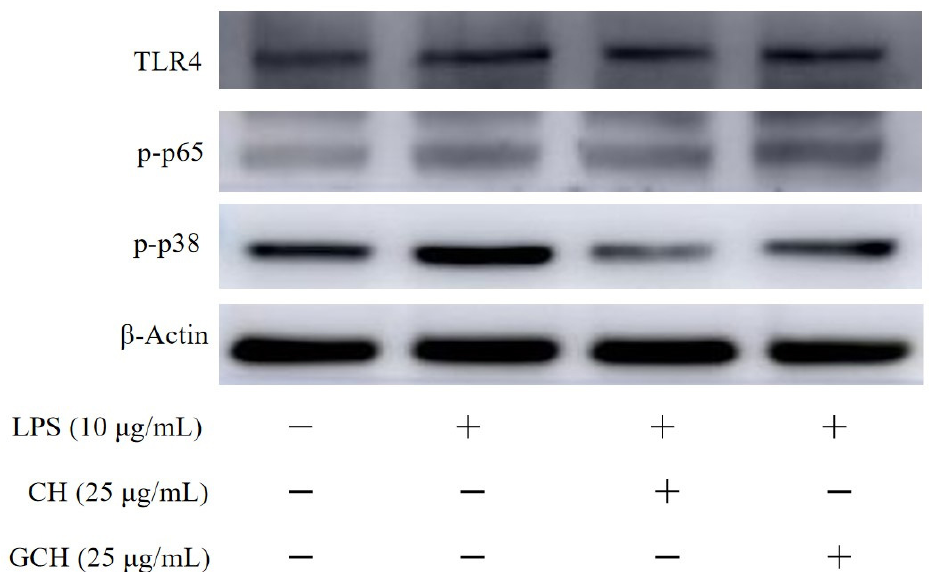
Figure 6. Western blotting assay results of the three proteins TLR4, p-p65, p-p38 in the IEC-6 cells treated with or without casein hydrolysate (CH) and glycated casein hydrolysate (GCH) at a dose of 25 µ g/mL for 24 h or LPS treatment (10 µ g/mL) of 24